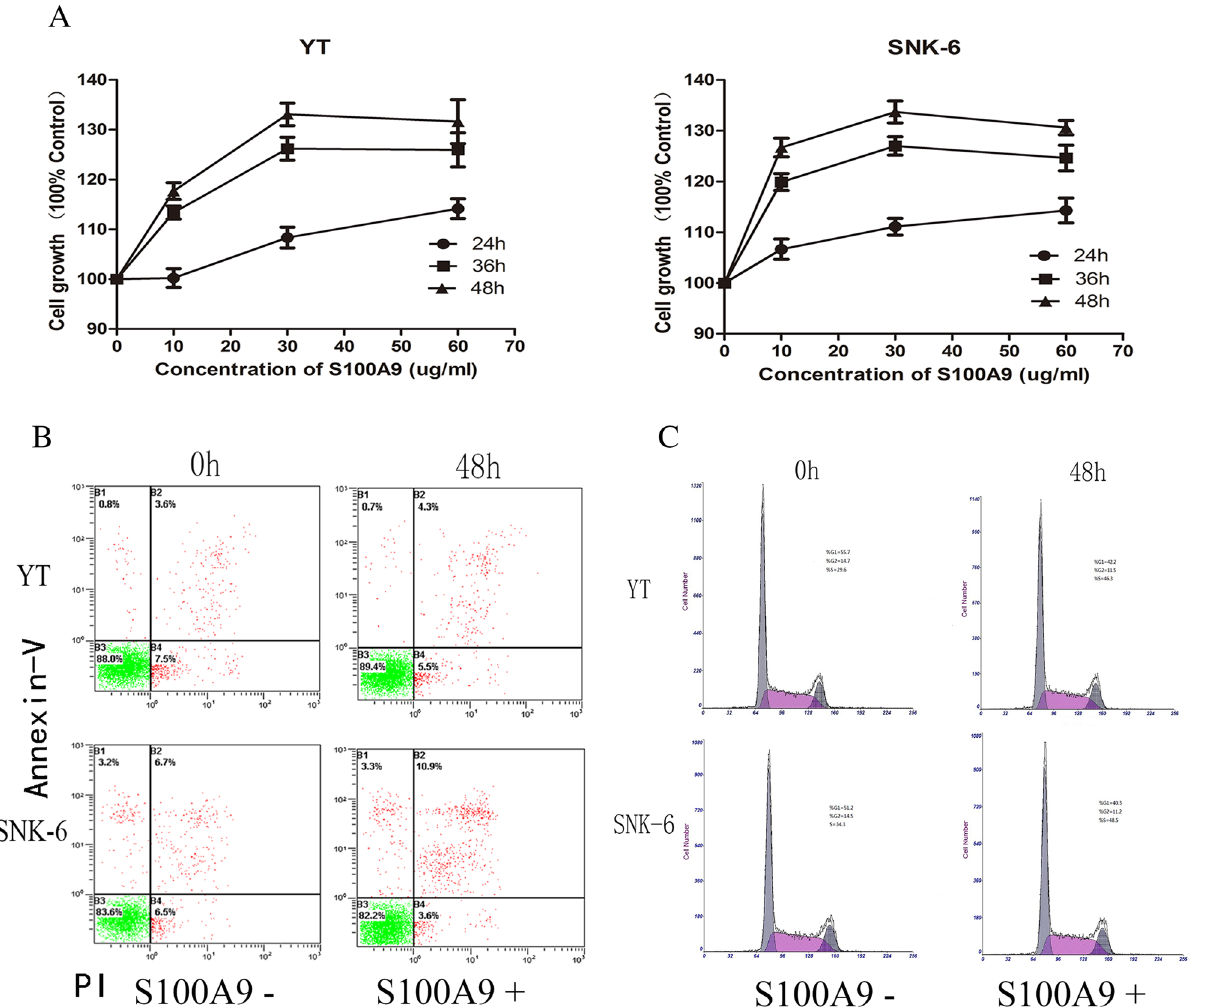
Figure 4. Effects of S100A9 on NKTCL cells (YT and SNK-6). ( a ) NKTCL cells were treated with different concentrations of S100A9 protein. CCK-8 assay showed low and mediate concentrations of S100A9 protein promoted proliferation of NKTCL cells. ( b ) NKTCL cells were exposure to S100A9 at the concentration of 30ug/ mL for 48 h. Cell apoptosis and cell cycles of NKTCL cells were not affected by S100A9